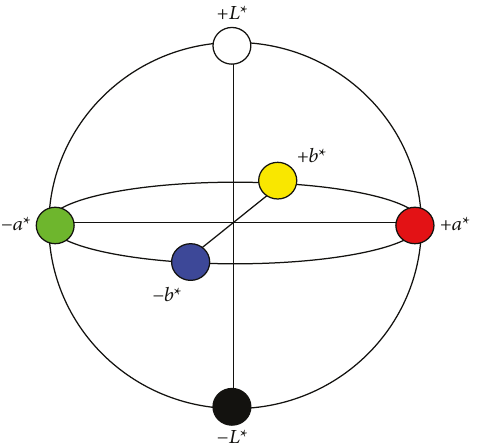
Figure 1: Representation of color solid for L ∗ a ∗ b ∗ color